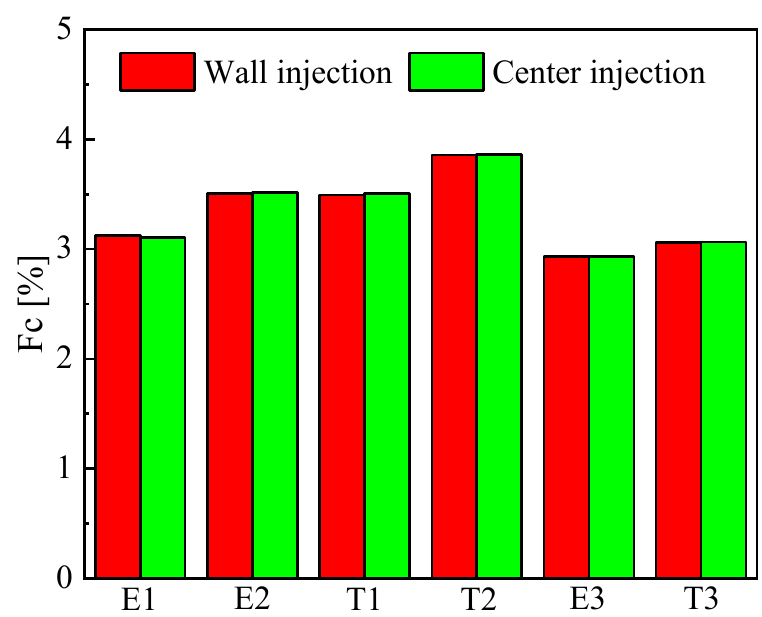
Figure 12. The variation of the situation field synergy degree.